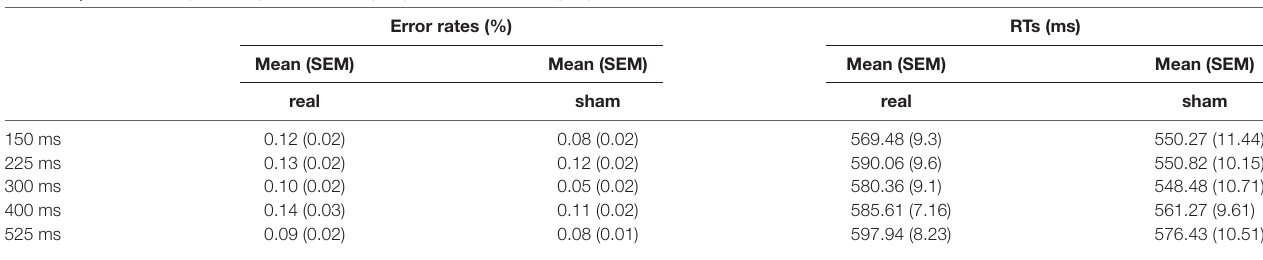
TABLE 1 | Mean values (and SEM) of error rates (ERs) and reaction times